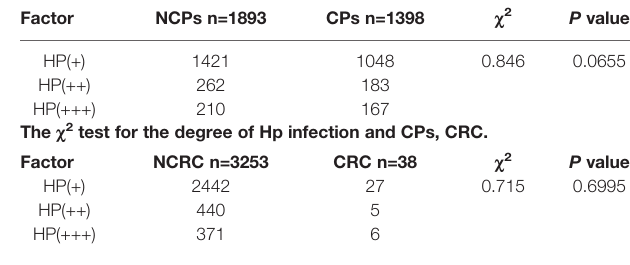
TABLE 6 | Analysis of Hp infectious